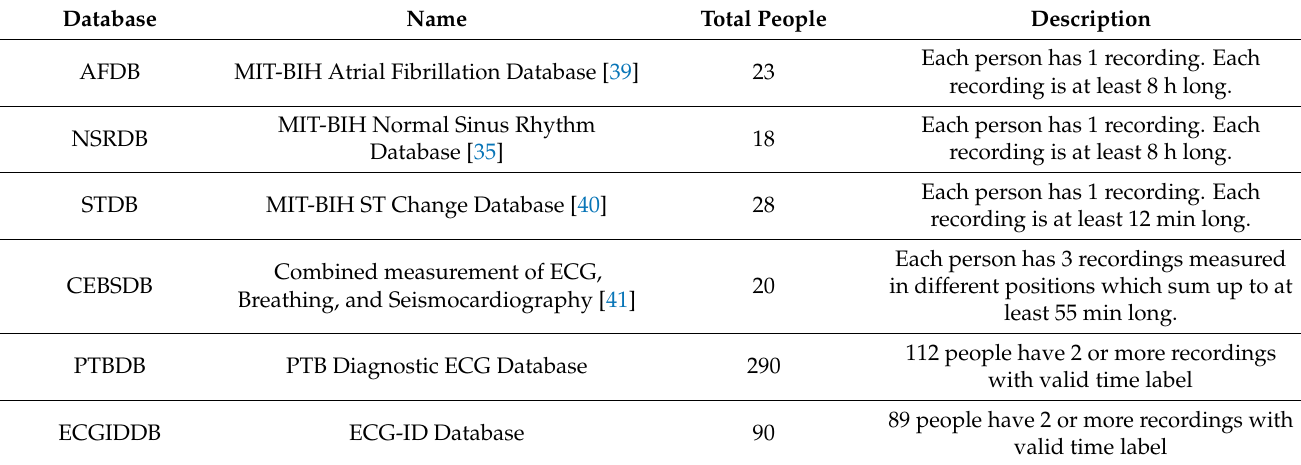
Table 5. ECG databases used for testing.